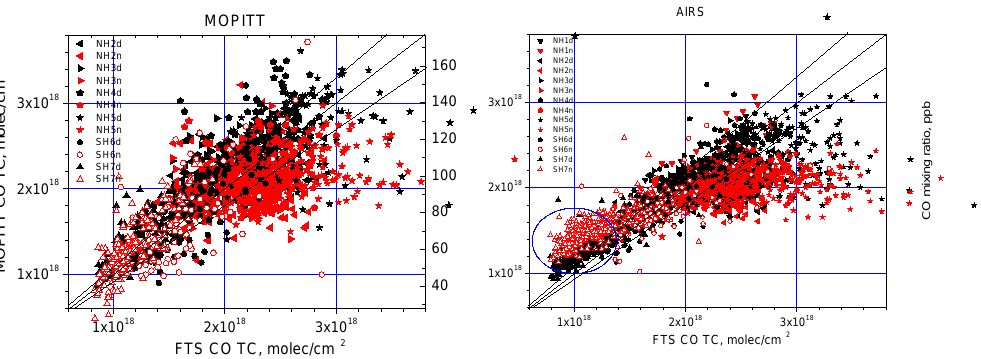
Fig. 4. Scattergrams of daily mean CO TC simultaneously measured by two satellite sounders and six FTS (MOPITT case) or seven FTS (AIRS case) for all matching days. Lines of equal TC and ± 10% are shown. Ground-based sites are designated according to Table 1, e.g., NH2d means Kiruna day-time satellite measurements, SH7n means Lauder night-time satellite measurements, etc. Encircled points for AIRS are for the lowest measured TC. Right scales are approximate mean mixing ratios in ppb (TC/2.15 × 10 25 ) .